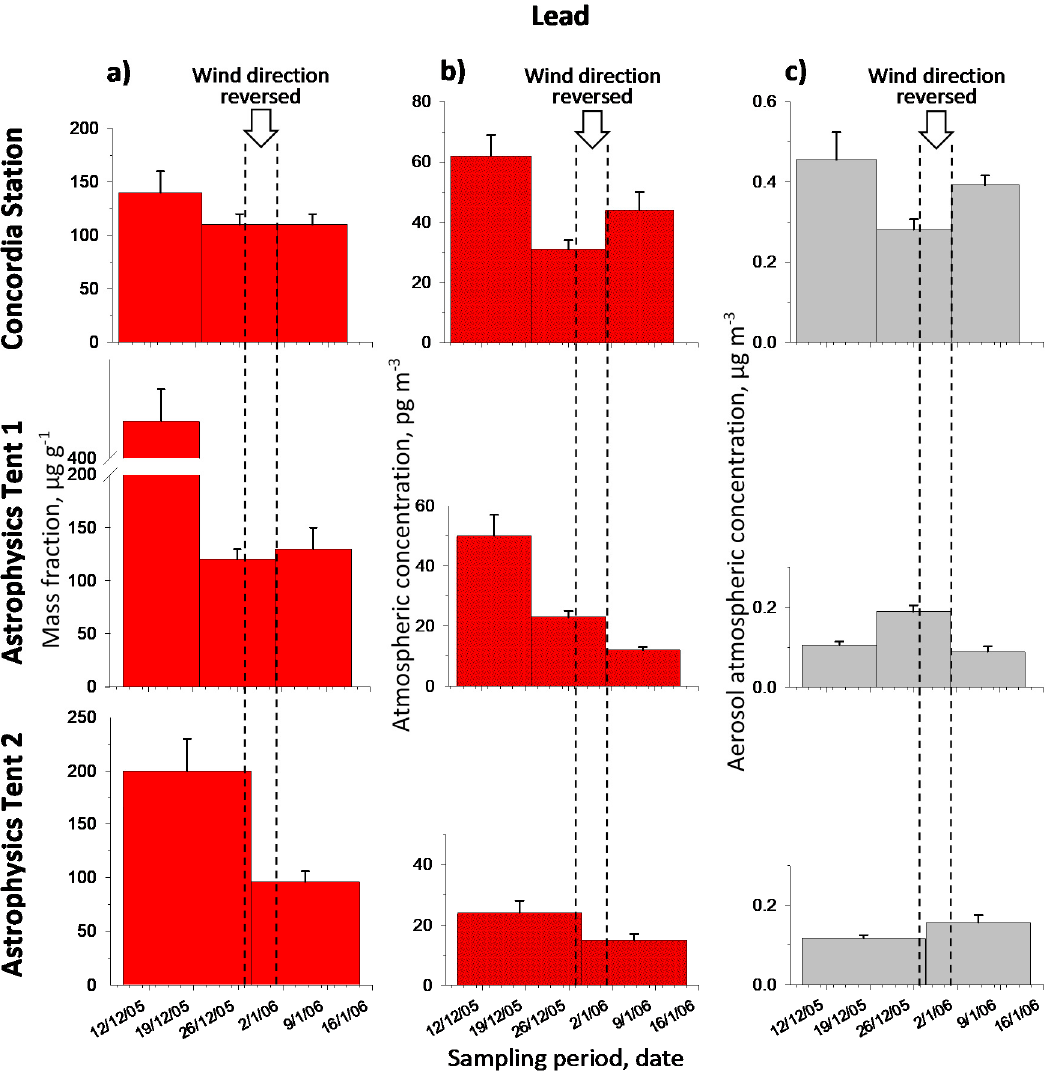
Figure 3. Temporal trends of Pb content at Dome C during the 2005–2006 austral summer, for ( a ) mass fraction and ( b ) atmospheric concentration. In ( c ), aerosol atmospheric concentration reported for comparison (redrawn from [42]).